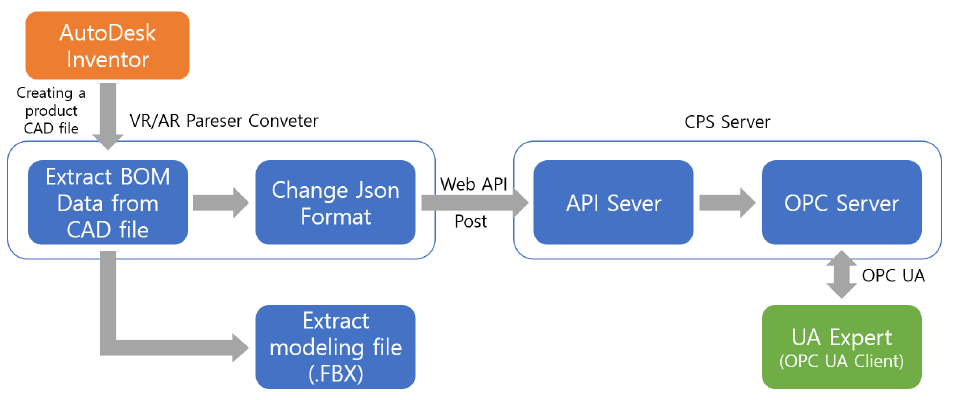
Figure 16. Experiment diagram.